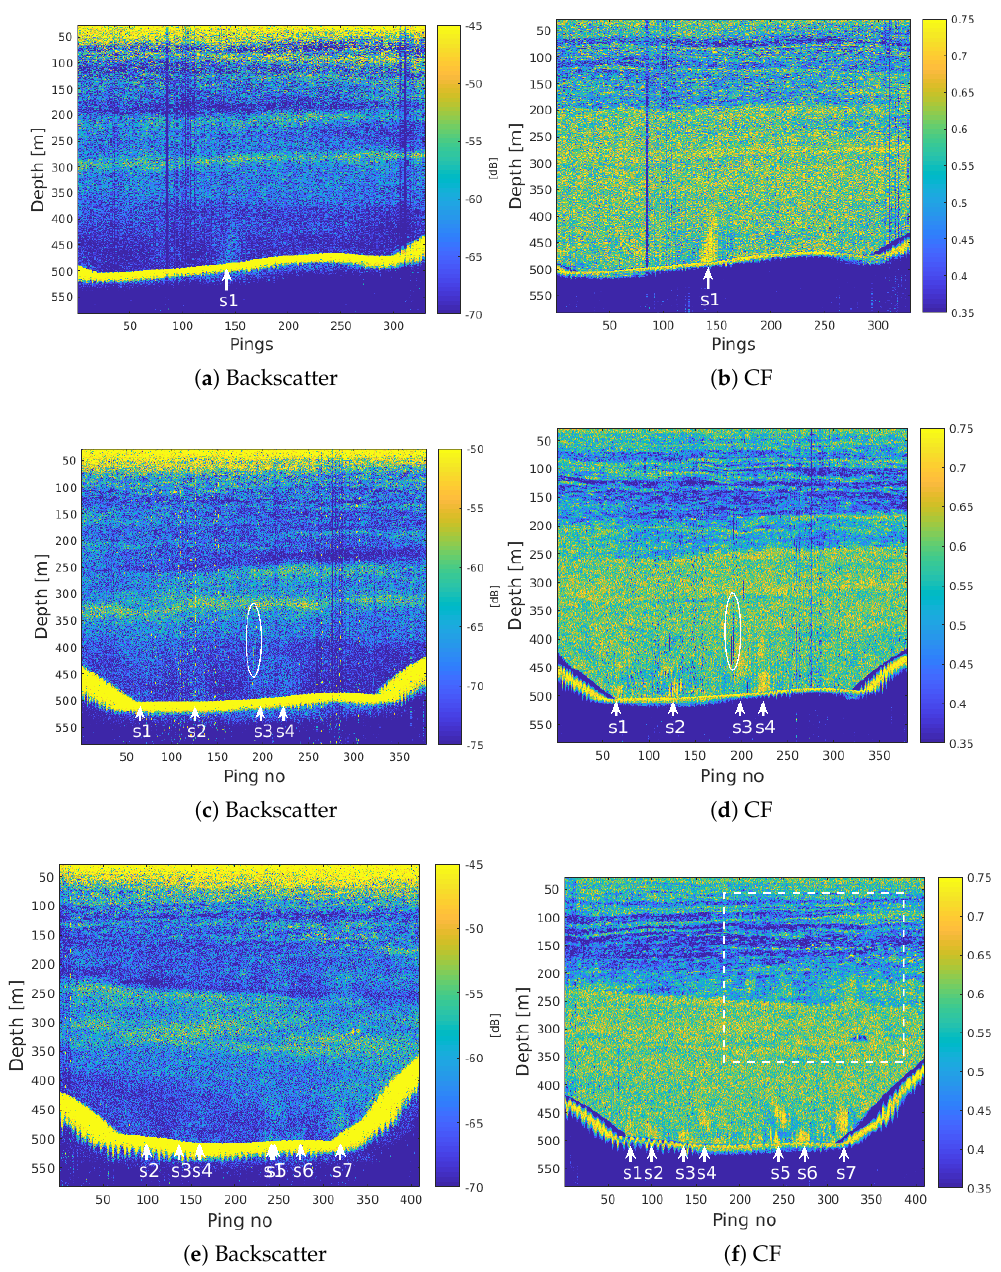
Figure 3. Water column backscatter images (left column), and corresponding CF images (right column), from three crosslines in the Hudson Canyon. The data were acquired using the Simrad EK80 SBES with an operating frequency centered at 37 kHz and a 25 kHz bandwidth. A vertical (depth) lowpass filter of 90 samples (corresponding to 2 m) was applied to all images for improved visualization. Notice that the scattering layers are more clearly defined in the CF image, and more details are visible. Seep positions obtained from visual inspection of the CF images are indicated by white arrows. We also observe that horizontal scattering layers are more clearly defined in the CF images, and that strong scatterers possibly related to fish or single bubbles are enhanced. The region indicated by the white rectangle in ( f ) is enlarged in Figure